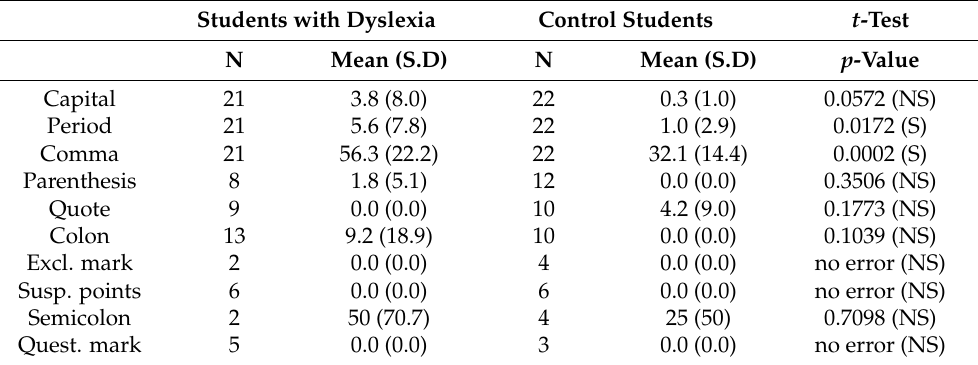
Table 7. Missing rates for each category of punctuation (mean, SD, and Welch p -value: NS = non significant/S = significant). Students with Dyslexia Control Students t -Test N Mean (S.D) N Mean